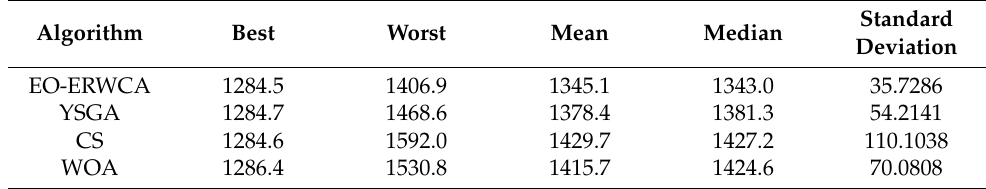
Table 3. Statistical measures of the results obtained with the different algorithms.